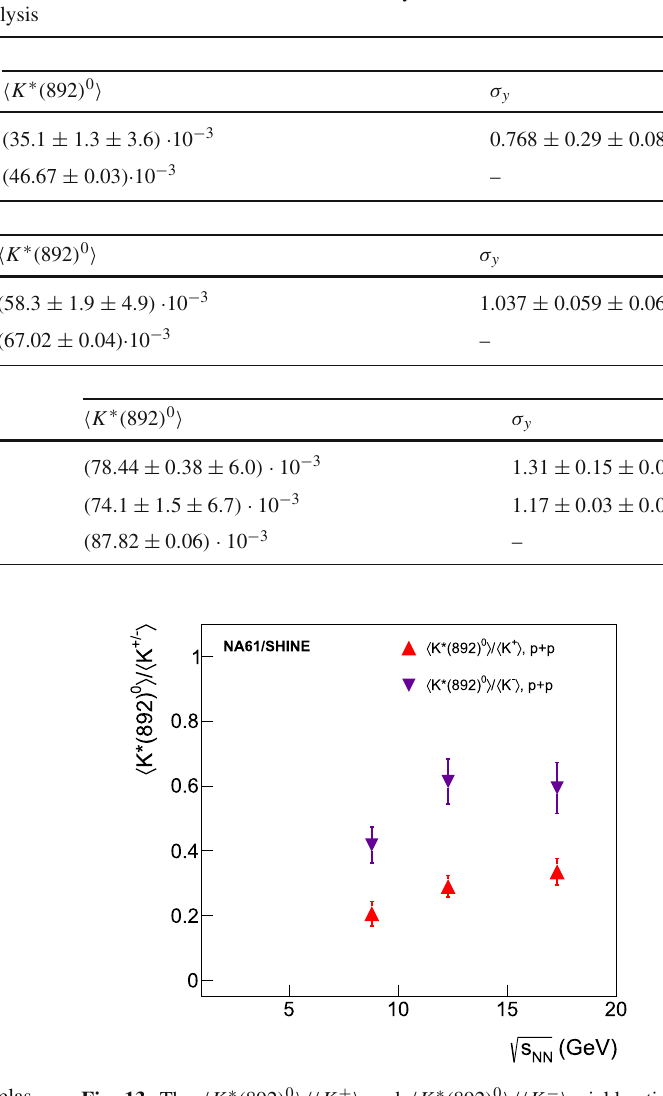
nucleus ( A + A ) collisions [8]. This is done based on the ratio of the K ∗ / K produced in A + A and p+p collisions. The (cid:8) K ∗ ( 892 ) 0 (cid:9) / (cid:8) K + (cid:9) and (cid:8) K ∗ ( 892 ) 0 (cid:9) / (cid:8) K − (cid:9) ratios in p+p